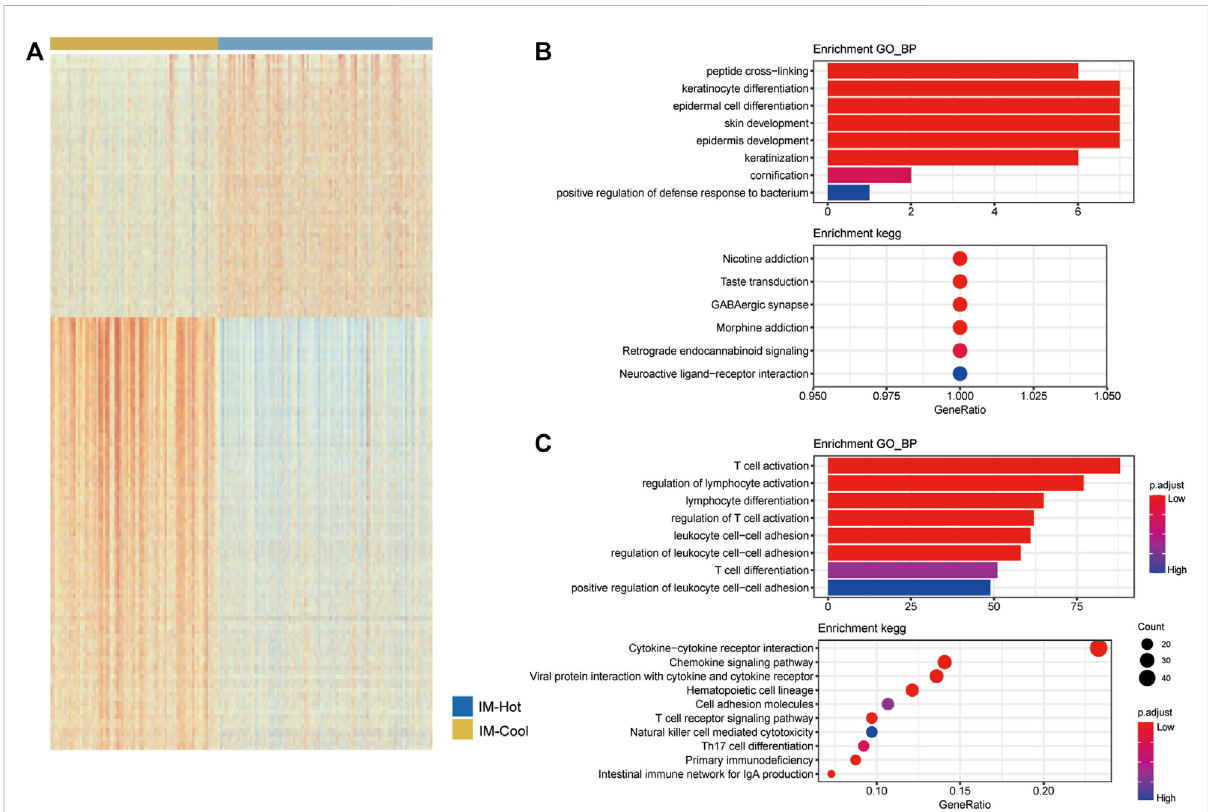
FIGURE 4 GOandKEGGanalysisresultsofgenes. (A) TheheatmapshowingtheDEGsinthetwosubtypeTCGAcohorts. (B)